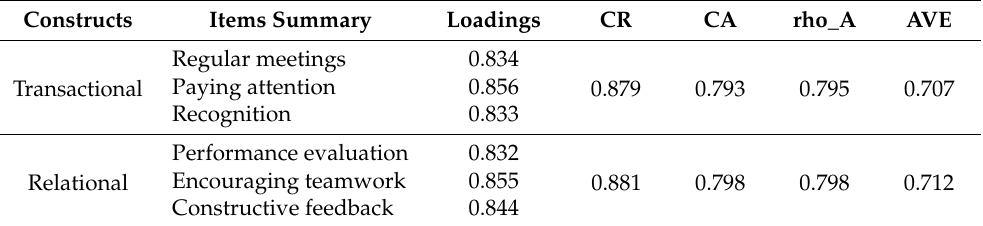
Table 3. Psychometric properties for first order constructs.